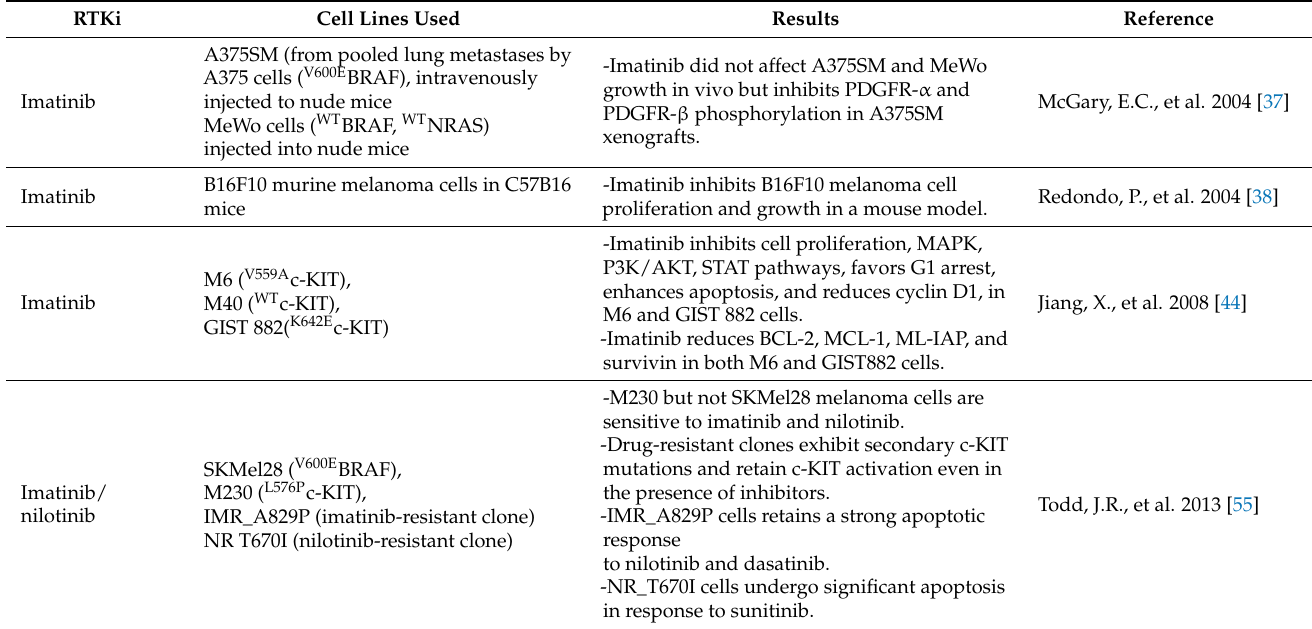
Table 1. Summary of the effect of different KIT inhibitors evaluated in melanoma preclinical studies. RTKi Cell Lines Used Results Reference -Imatinib did not affect A375SM and MeWo growth in vivo but inhibits PDGFR- α and Imatinib PDGFR- β phosphorylation in A375SM injected into nude mice